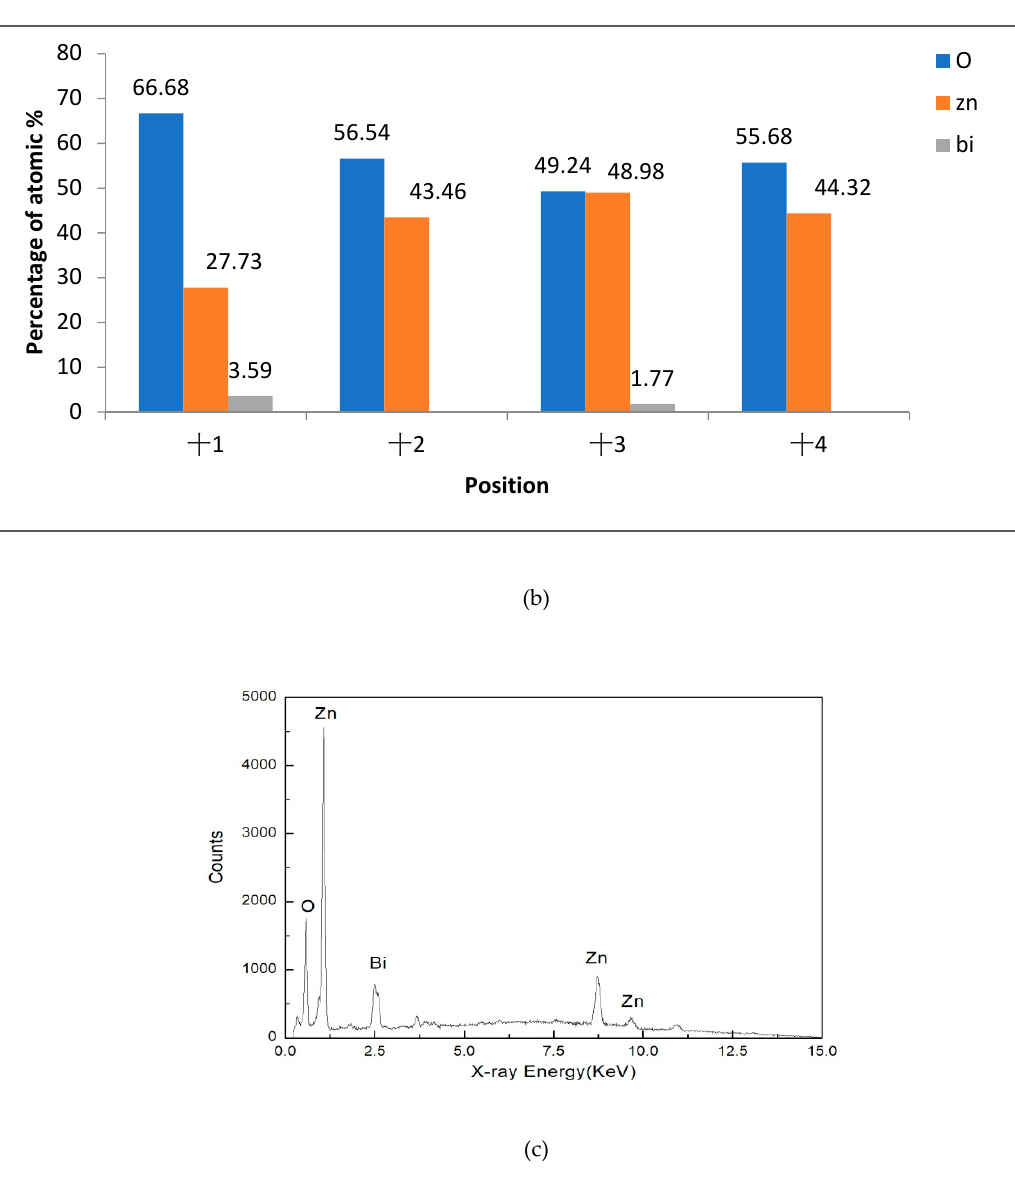
Figure 8. ( a ) SEM images of the ZnO varistors (resolution of 10 μ m); ( b ) EDS analysis results of the ZnO varistors. (+1, +2, +3, +4); ( c ) Map analysis at the +1 position of the ZnO varistors.